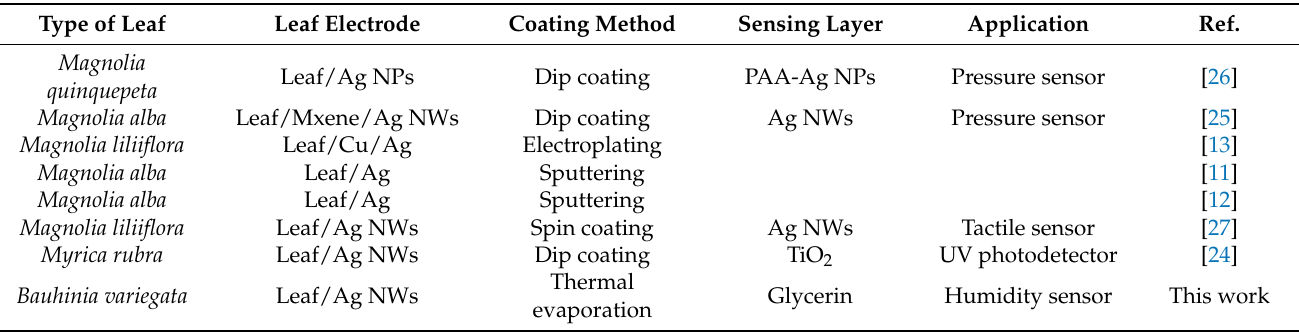
Table 1. Bio-inspired leaf vein-based devices for different